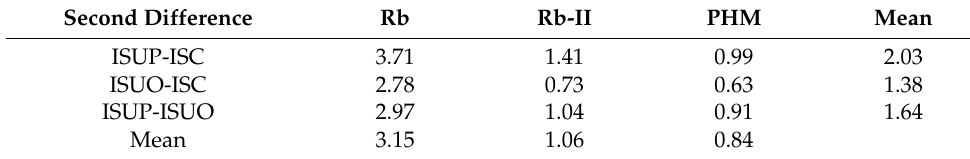
Table 4. The average STD statistics of different atomic clocks (ns). Second Difference Rb Rb-II PHM Mean